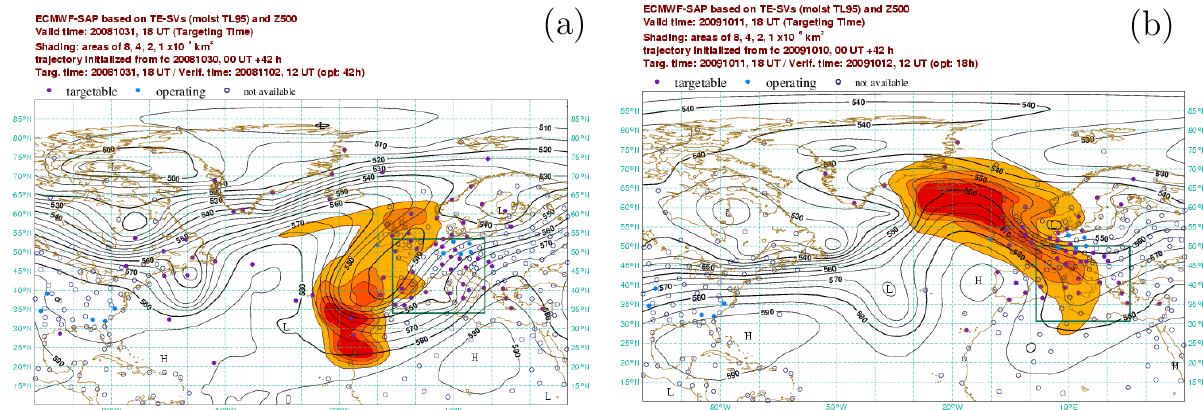
Fig. 2. Sensitive area prediction from ECMWF-SAP (shaded) along with 500hPa geopotential height ECMWF forecast (contour) at the target time for case 863 (a) and 1025 (b) . The verification area is marked with a green rectangle and circles identify radiosonde stations that were either available for targeting (purple), operating routinely at target time (blue) or not available at that time.